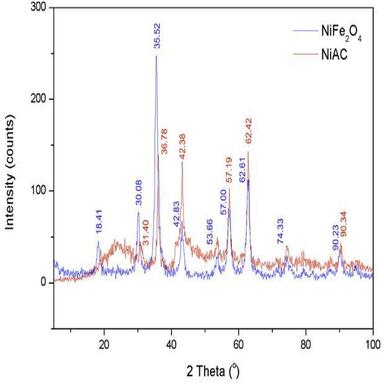
XRD patterns of NiFe2O4 (blue line) and NiAC (red line). (For interpretation of the references to color in this figure legend, the reader is referred to the Web version of this article.)